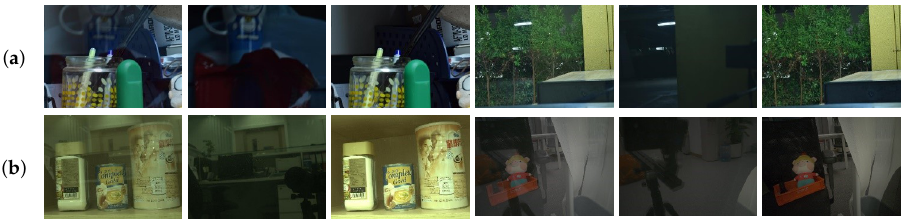
Figure 7. Some examples from the existing data set [13,41]. ( a ) from [41] and ( b ) from [13]. Synthetic Data Generation